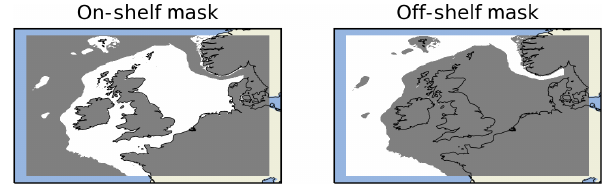
Figure 9. On-shelf and off-shelf masking regions within the co- located AMM7 and AMM15 domain (data within the grey areas are